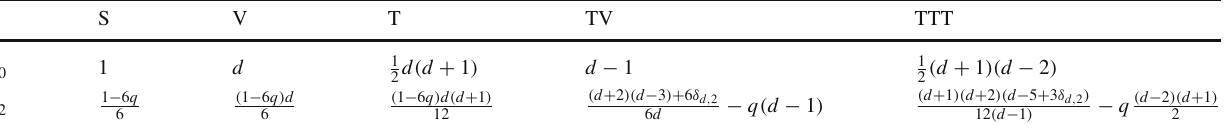
Table 3 Heat-kernel coefficients for fields with differential constraints on the product manifold S 1 × S d . The labels indicate that the result- ing a i have been computed for spacetime scalars (S), spatial vectors